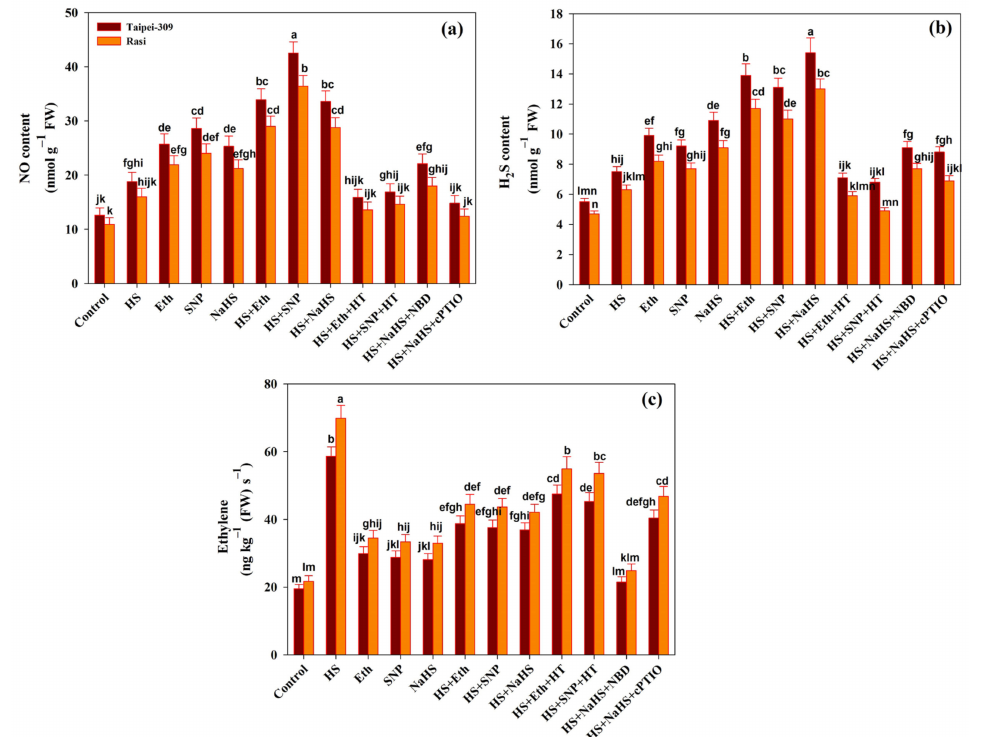
Figure 3. Content of ( a ) Nitric oxide (NO), ( b ) hydrogen sulfide (H 2 S), and ( c ) ethylene evolution in rice ( Oryza sativa L.) cultivars Taipei-309 and Rasi under control and high temperature stress (HS) sup- plied with 200 µ L L − 1 ethephon (Eth), 100 µ M sodium nitroprusside (SNP), 200 µ M sodium hydrosul- fide (NaHS) or 100 µ M hypotaurine (HT), 100 µ M 2-4-carboxyphenyl-4,4,5,5-tetramethylimidazoline- 1-oxyl-3-oxide (cPTIO), or 100 µ M norbornadiene (NBD) scavengers of hydrogen sulfide (H 2 S), NO, and ethylene action inhibitors, respectively. Data are presented as treatments mean ± SE ( n = 4). The values followed by the same letters did not differ significantly by LSD test at p <